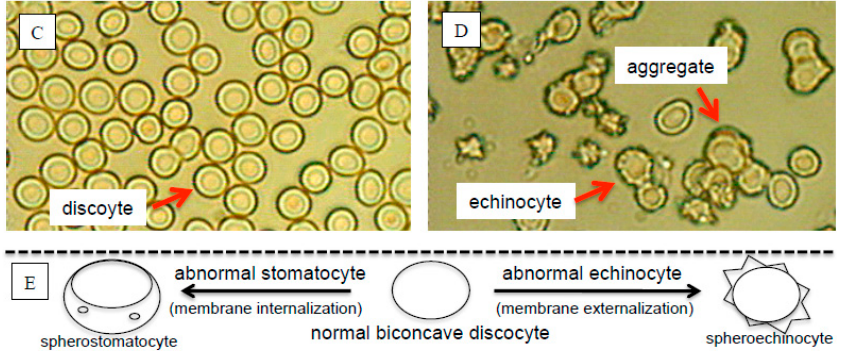
Figure 1. Sepsis alters erythrocyte morphology and blood flow in capillary networks. ( A , B ) Intravital multiphoton images of the extensor digitorum longus (EDL) hindlimb skeletal muscle microcirculation of a control and septic mouse, 5 h after the onset of septic injury, respectively (Bateman et al. [34]). Solid lines indicate perfused capillaries, whereas broken lines indicate stopped-flow capillaries. Capillaries were pseudo colored for depth below the surface: brown (surface), green (75 µm), blue (150 µm) (Bateman et al. [35]). ( C , D ) Blood smears from a healthy volunteer with normal red blood cell (RBC) discocyte morphology and a septic shock patient with abnormal RBC morphology, respectively. Note the presence of echinocytes (also reported by de Oliveira et al. [4]), RBC aggregates and